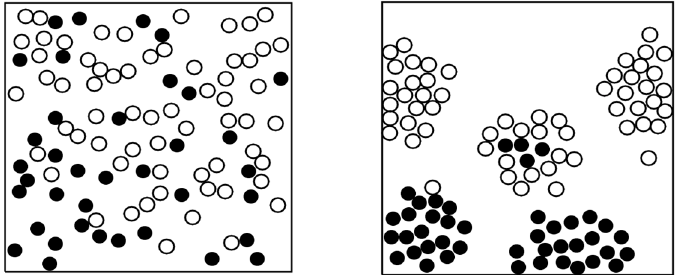
Figure 6. Distribution of failed fibers in the case of clustered and random homogeneous fiber arrangements. The case of 100 fibers, five clusters, vc = 20%, damage parameter of 0.37 in random structures, and 0.43 in clustered structures (reprinted from [34] with kind permission from Elsevier).